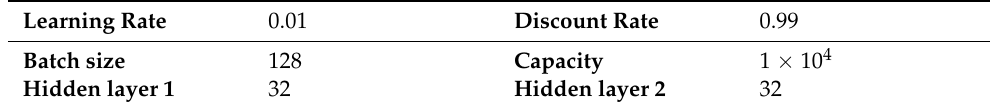
Table 1. Hyperparameters of the algorithm.